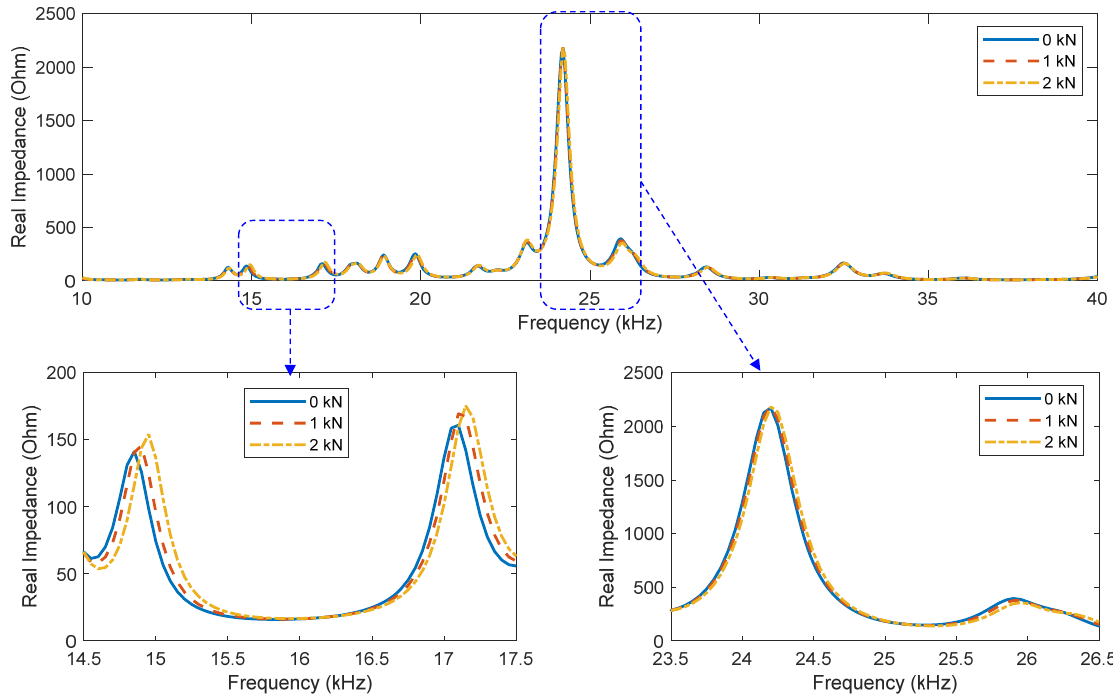
Figure 6. Impedance responses of two PZT interfaces under an ascending concentrated load.